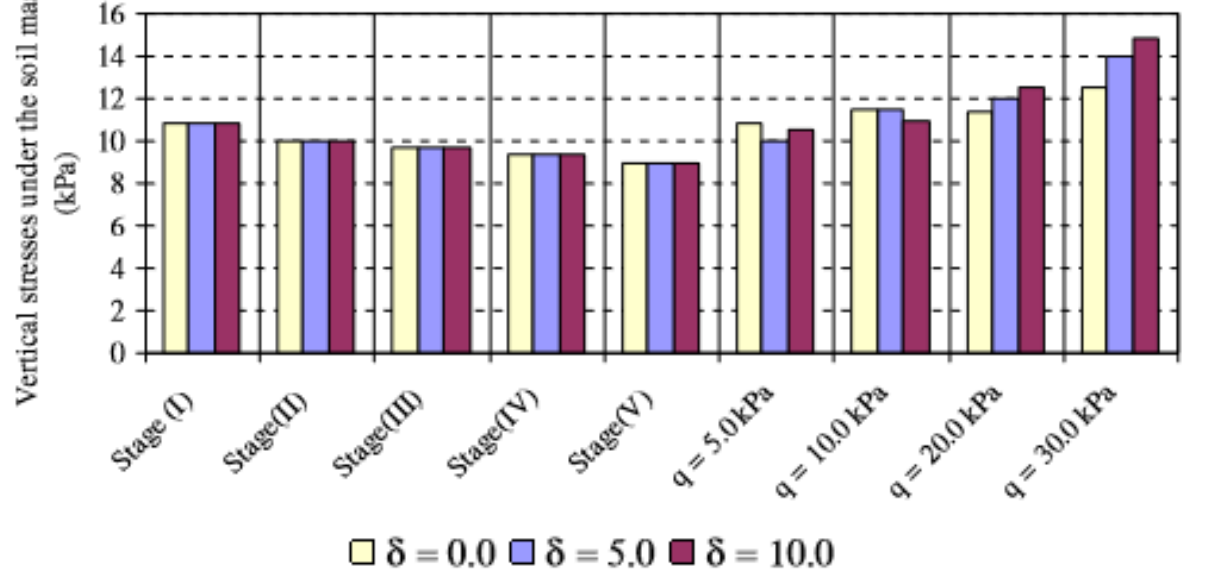
Figure 19. Influence of nail inclination on the slope face vertical stresses at mid height of slope.